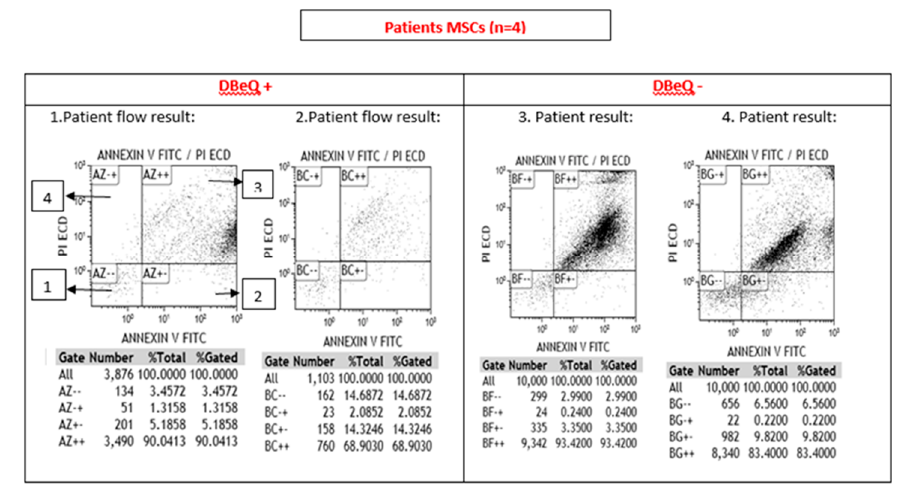
Figure 1. The schematic representation of the graph for apoptosis analysis in flow cytometry is shown in the 1st patient flow results. Field 1 shows live cells. Field 2 shows early apoptotic cells. Field 3 shows late apoptotic. cells. Field 4 shows necrotic cells. Therefore, it is important the results to compare the apoptotic cells after incubating with the inhibitor, to compare the live cells before incubating with the inhibitor.